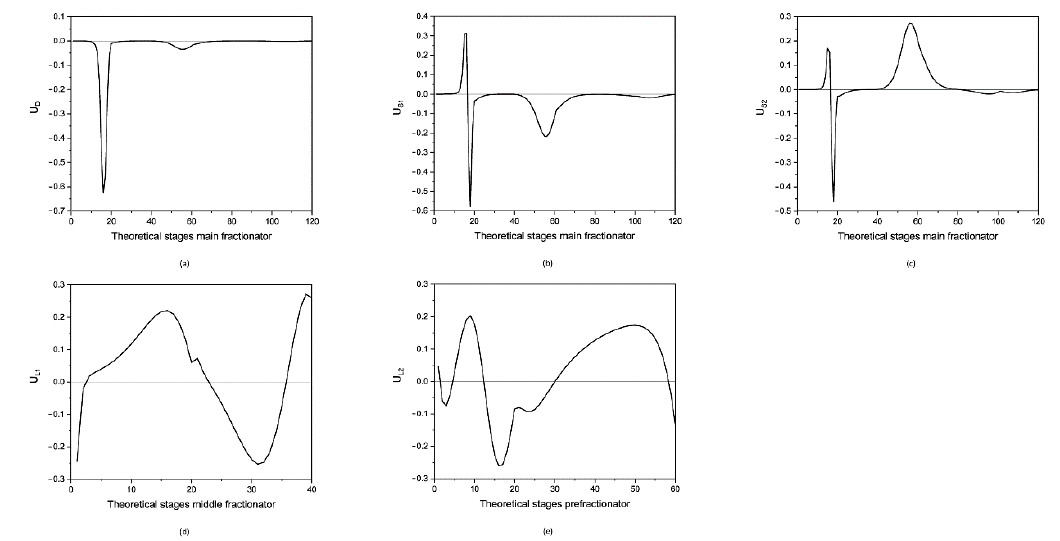
Figure 5. SVD analysis for mixture 2: ( a ) distillate, ( b ) side draw 1, ( c ) side draw 2, ( d ) liquid split 1, and ( e ) liquid split 2.